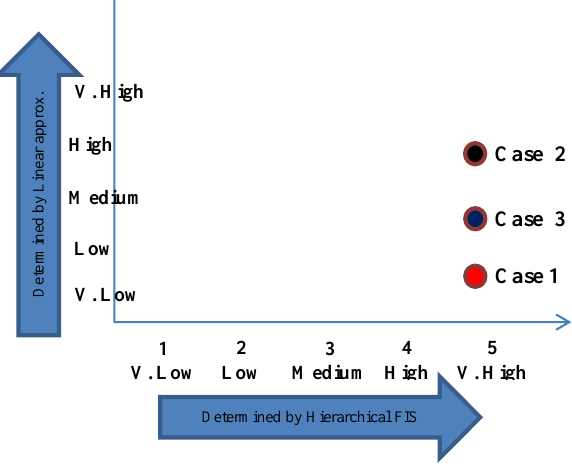
Figure 8. Risk mapping of three sample cases using hybrid approach.